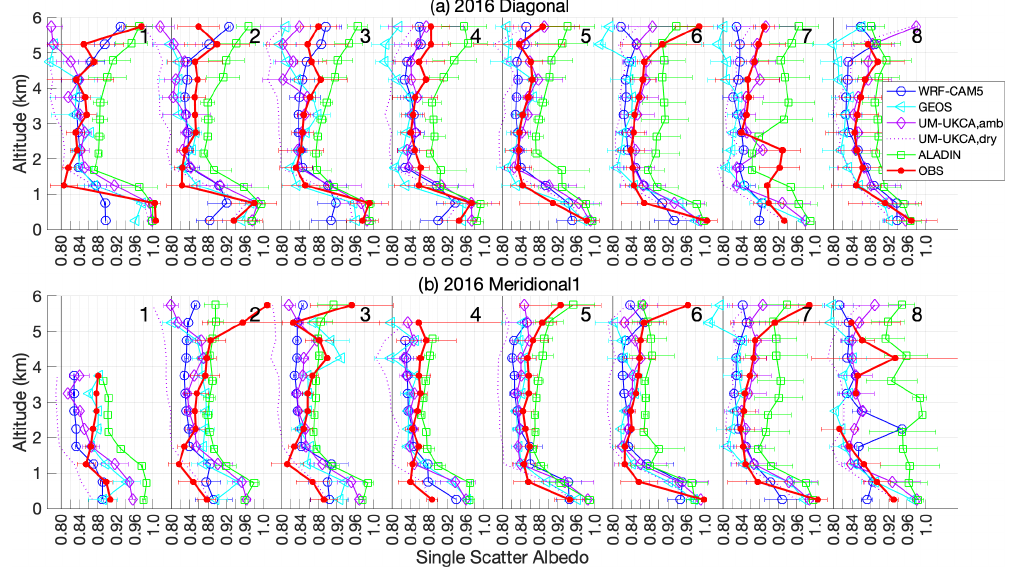
Figure 16. Profiles of SSA as observed (at low RH and 530nm) and modeled (at ambient RH and also, for UM-UKCA, dry, at 550nm) for the 2016 (a) diagonal and (b) meridional 1